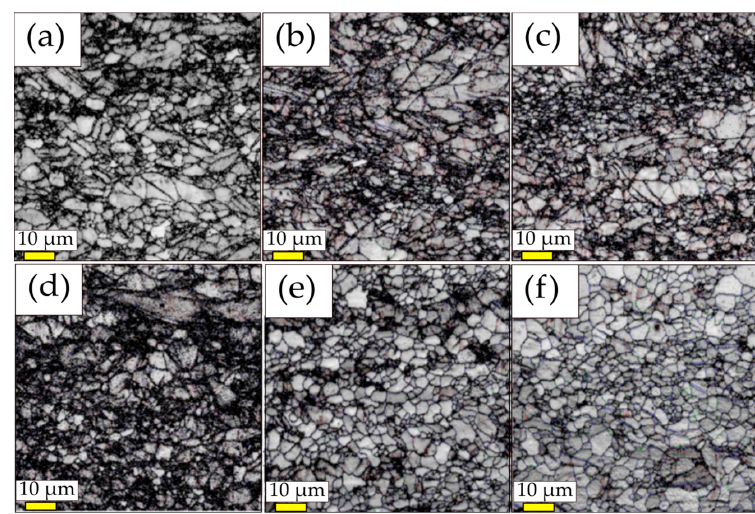
Figure 3. The electron back-scattered diffraction (EBSD) image quality (IQ) maps at the middle of longitudinal cross-sections of the sheet (rolling direction (RD) is the normal direction of figures plane) with speed ratio (SR) of ( a ) 1.0, ( b ) 1.1, ( c ) 1.2, ( d ) 1.5, ( e ) 2.0 and ( f ) 3.0 [40]. The speed ratio between the upper and lower rolls varied from one to three with the speed of lower roll fixed as three rpm (roll diameter of 400 mm). Reproduced with permission from Kim et al., J. Alloys Comp ; published by Elsevier, 2011.